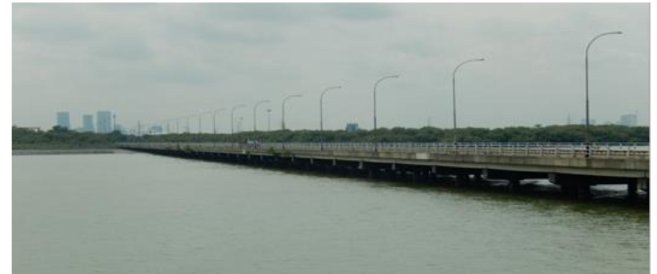
Figure 1. The view of the RC bridge in TPS (from the domestic harbor).